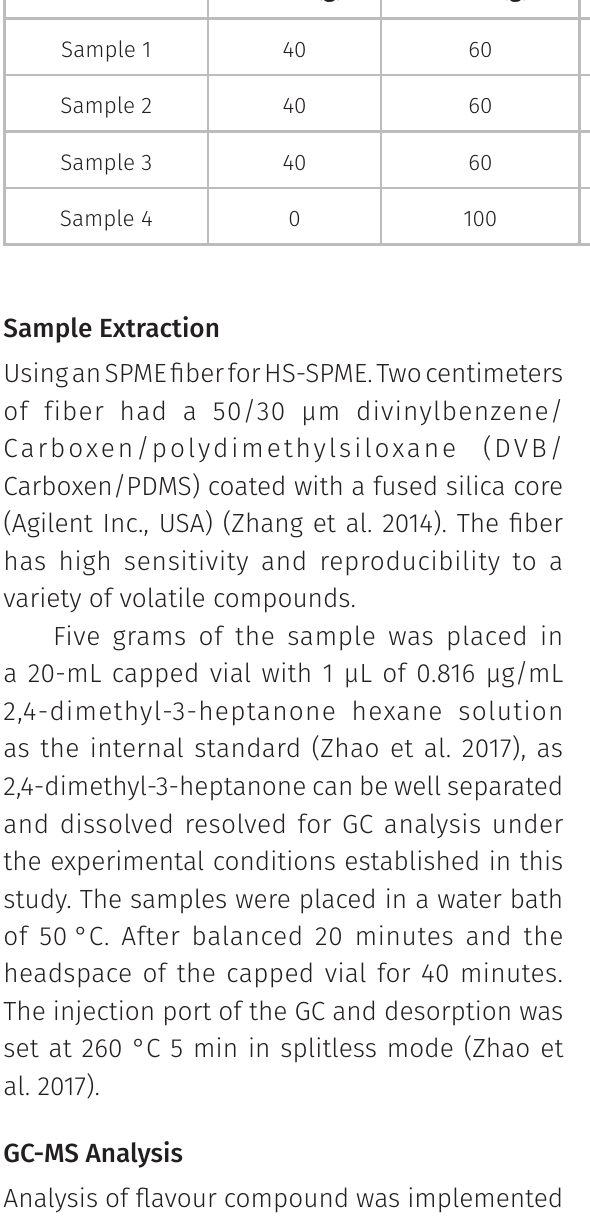
Potato flour Wheat flour added (g) added (g)